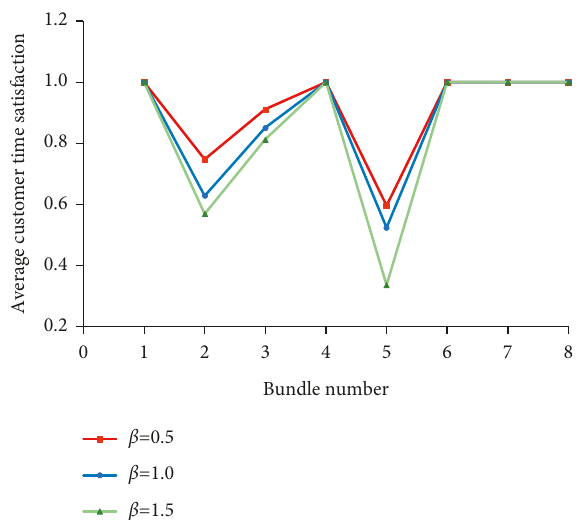
Figure 10: Comparison on heterogeneous time-sensitive customer satisfaction.